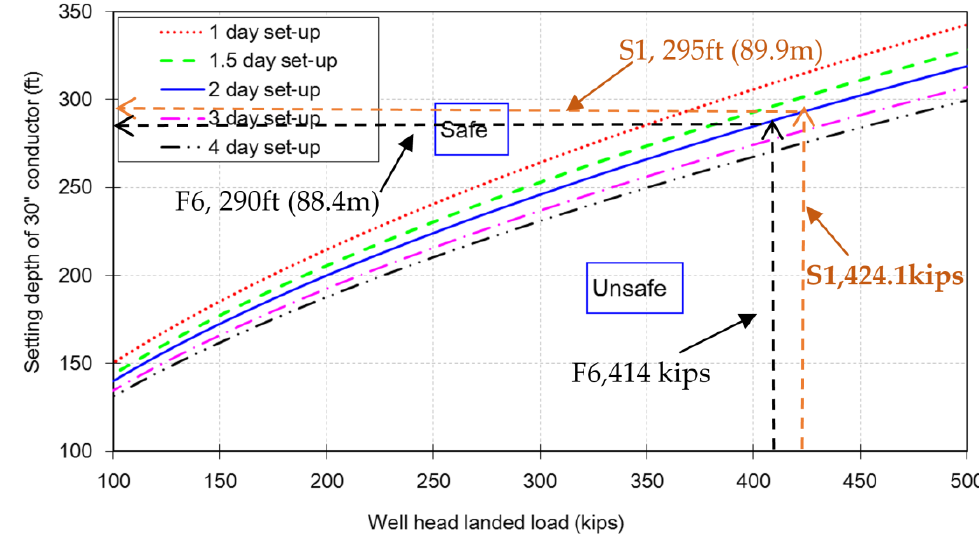
Figure 9. Landed weight vs setting depth of 30 ″ surface conduit.